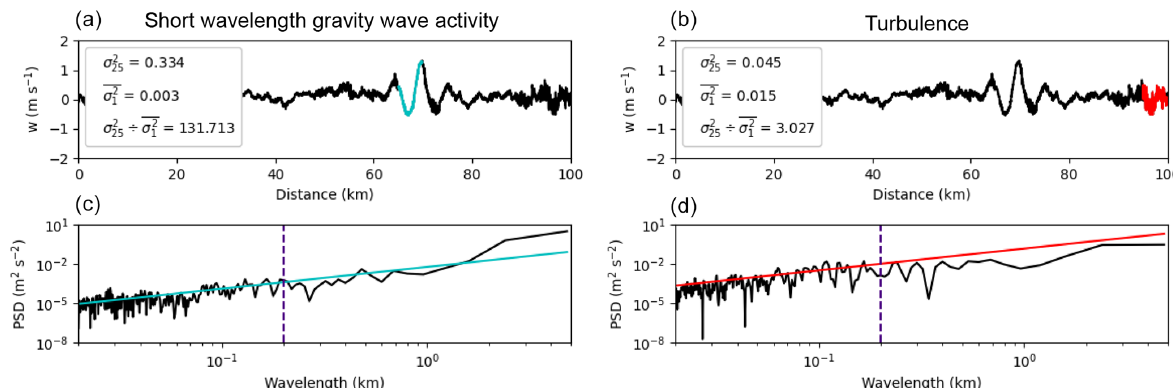
Figure C1. (a, b) Vertical wind time series from example 4 in Fig. 5, with specific 5km sections of interest highlighted in cyan (a) and red (b) . σ 2 w 25 , σ 2 w 1 , and σ 2 w 25 /σ 2 w 1 for the highlighted sections are printed on the plots. (c, d) Power spectral density for the highlighted 5km sections (black), with lines fitted to k − 5 / 3 between 20 and 100m (cyan and